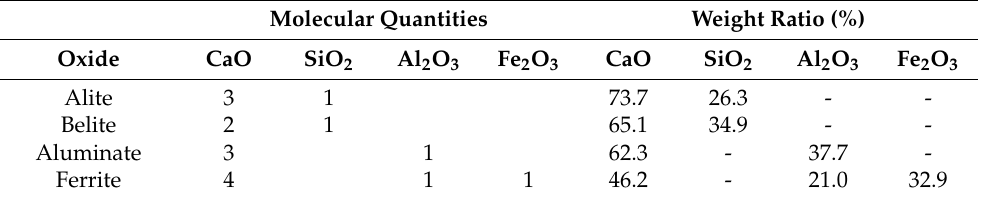
Table 4. Chemical compositions of cement compounds derived from the Bogue models